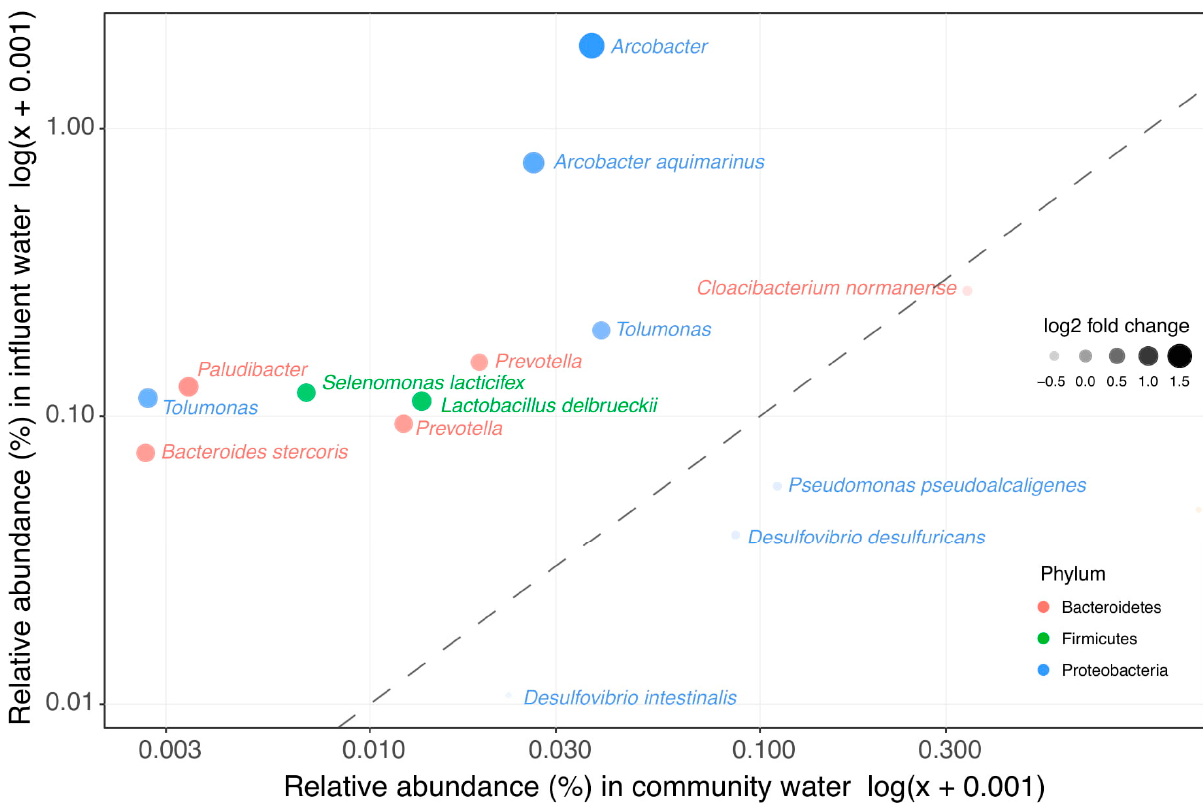
Figure 3. Clinical enriched taxa in influent vs. wastewater collected from households. The 207 taxa found to be enriched in clinical wastewaters were compared in their relative abundance in influent and in the wastewater collected from households. In total, 10 taxa were significantly more abundant in influent than in wastewater collected from households.